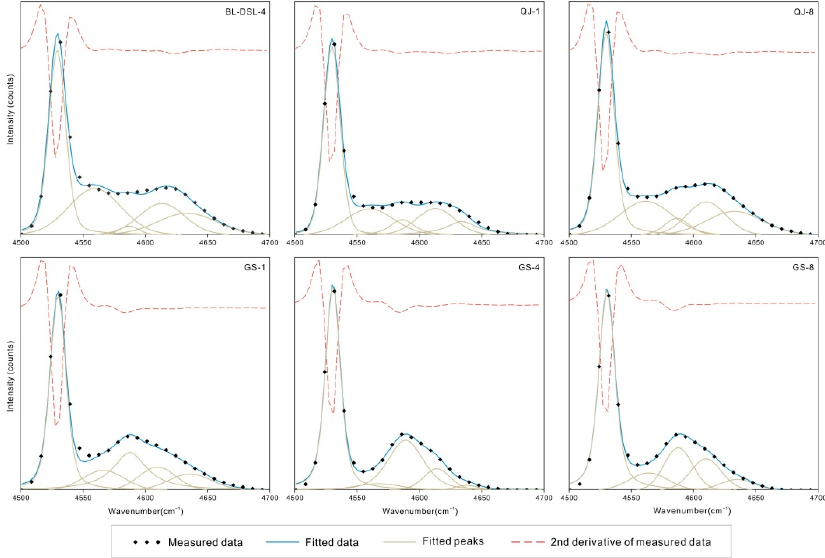
Figure 7. NIR spectral component analysis of the OH combination bands.